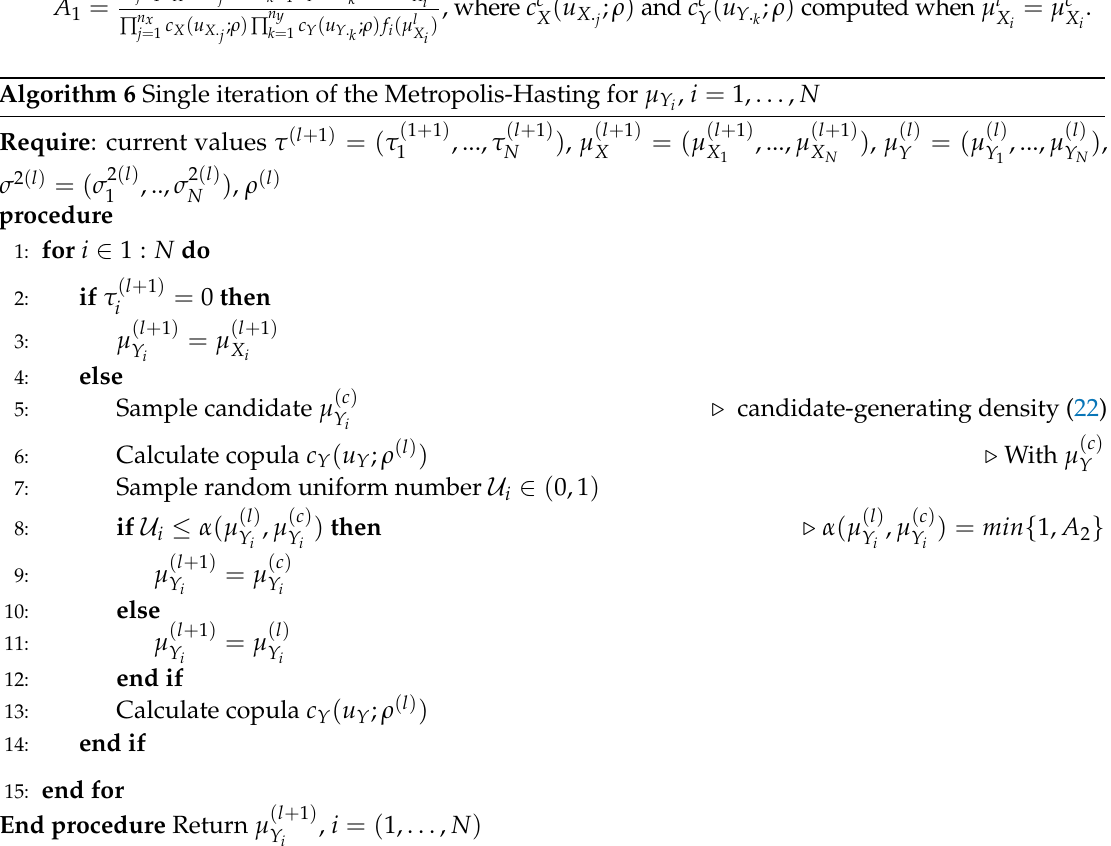
Algorithm 6 Single iteration of the Metropolis-Hasting for µ Y